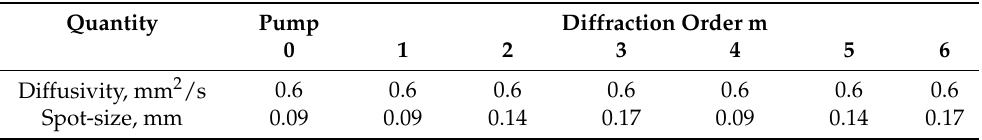
Figure 8. Lateral deflection data vs. offset: ( a ) amplitude for m = 0; ( b ) amplitude for m = 2; ( c ) phase for m = 0; ( d ) phase for m = 2. Continuous line is for the theoretical expectation from Equation (9). Symbols are for experimental data. For all figures, the red and blue symbols stand for RCP and LCP, respectively. Table 4. Sample effective thermal diffusivity and beam spot size for all the diffracted beams as calculated from the best fit procedure of the PDT data with Equation